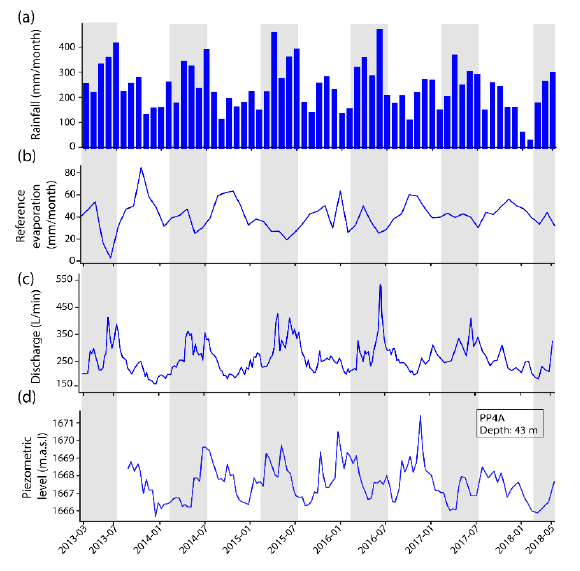
Figure 6. Time series of the ( a ) monthly rainfall, ( b ) monthly reference evaporation, ( c ) total discharge from 29 drains, and ( d ) piezometric level from the piezometer PP4A for the period 2013 – 2018. The shaded area indicates the rainy season. Time series plots for the 10 remaining piezometers and the individual 29 drains are shown in Appendix A.5, in Figures A7 and